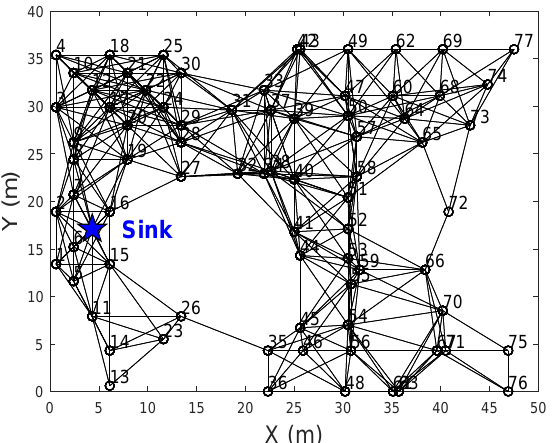
Figure 3. In the Soda network, 78 nodes were deployed following the Motescope testbed in 2007 in Soda Hall, University of California, Berkeley, California,